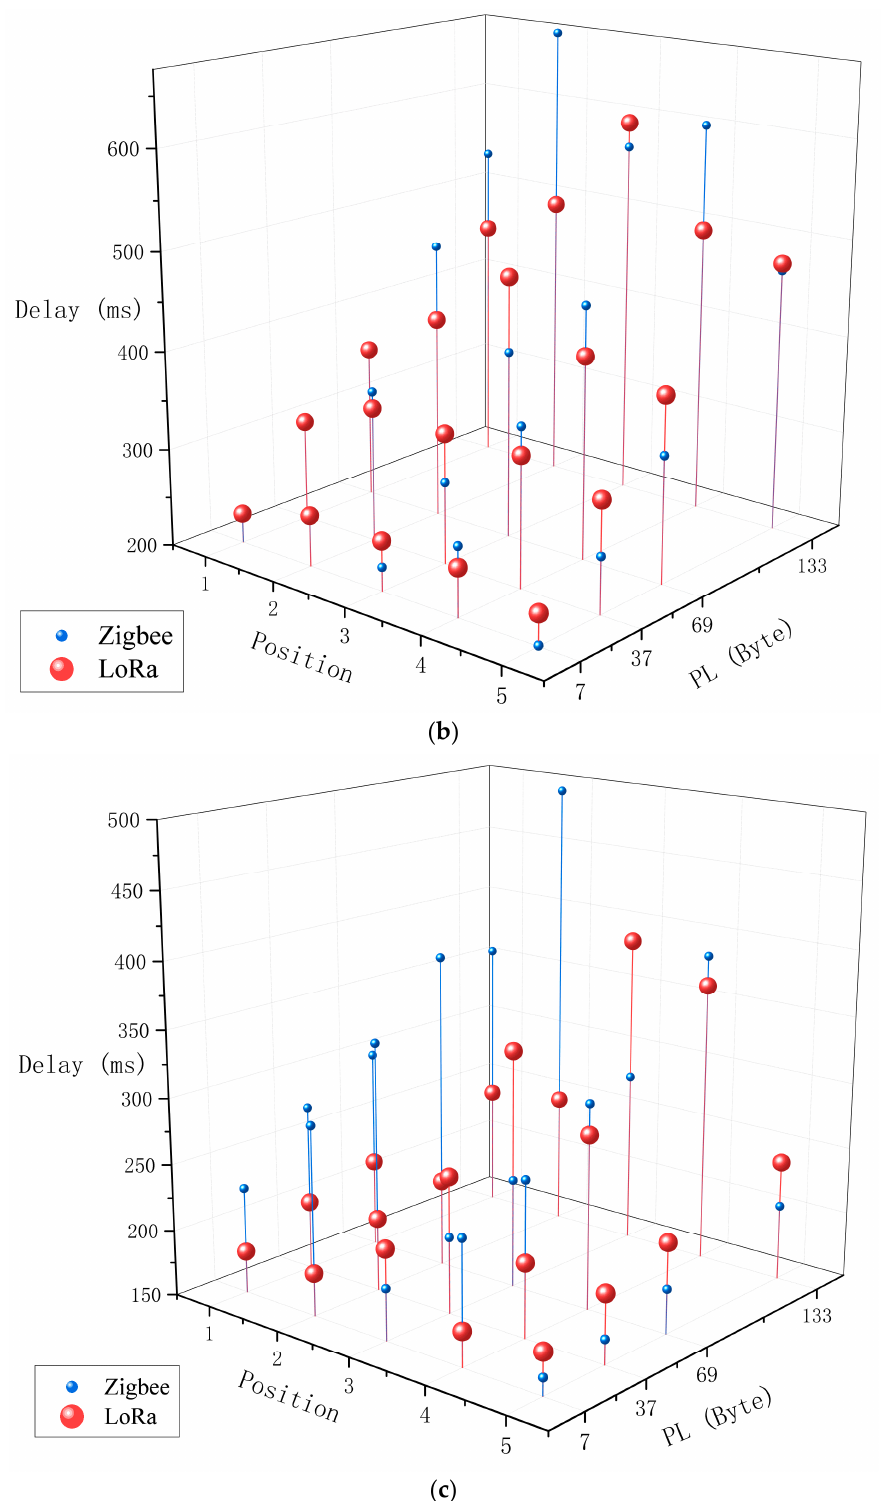
Figure 9. RTT in horizontal experiment: ( a ) Baud = 1200 bps; ( b ) Baud = 9600 bps; ( c ) Baud = 115,200 bps.